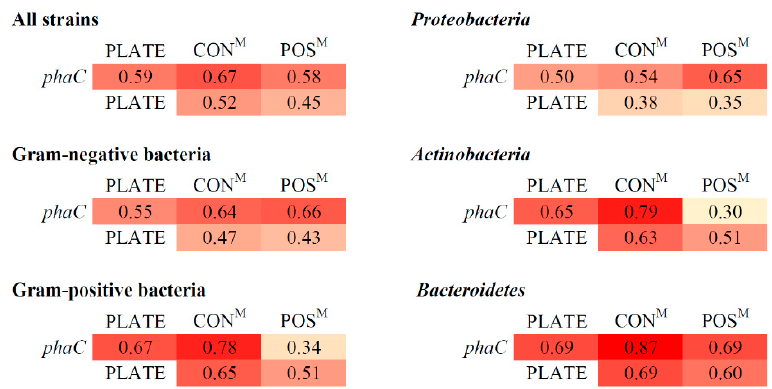
Figure 4. Simple matching coefficient calculated from the binary (positive/negative) data obtained from each screening method for the following subsets: all strains ( n = 200), Gram-negative bacteria ( n = 151), Gram-positive bacteria ( n = 49), Proteobacteria ( n = 106), Actinobacteria ( n = 43), Bacteroidetes ( n = 45). phaC —binary dataset of the presence/absence of the 550 bp DNA fragment of the phaC gene; PLATE—binary dataset of the presence/absence of the characteristic fluorescence on R3A agar plates with Nile Red after UV exposure; CON M —microscopy-obtained (M) binary dataset of the presence/absence of granules after incubation in R3A broth (constitutive producers); POS M —microscopy-obtained (M) binary dataset of the presence/absence of granules after incubation on ≥ 1 of the liquid media used (R3A, PIM1,2,3).